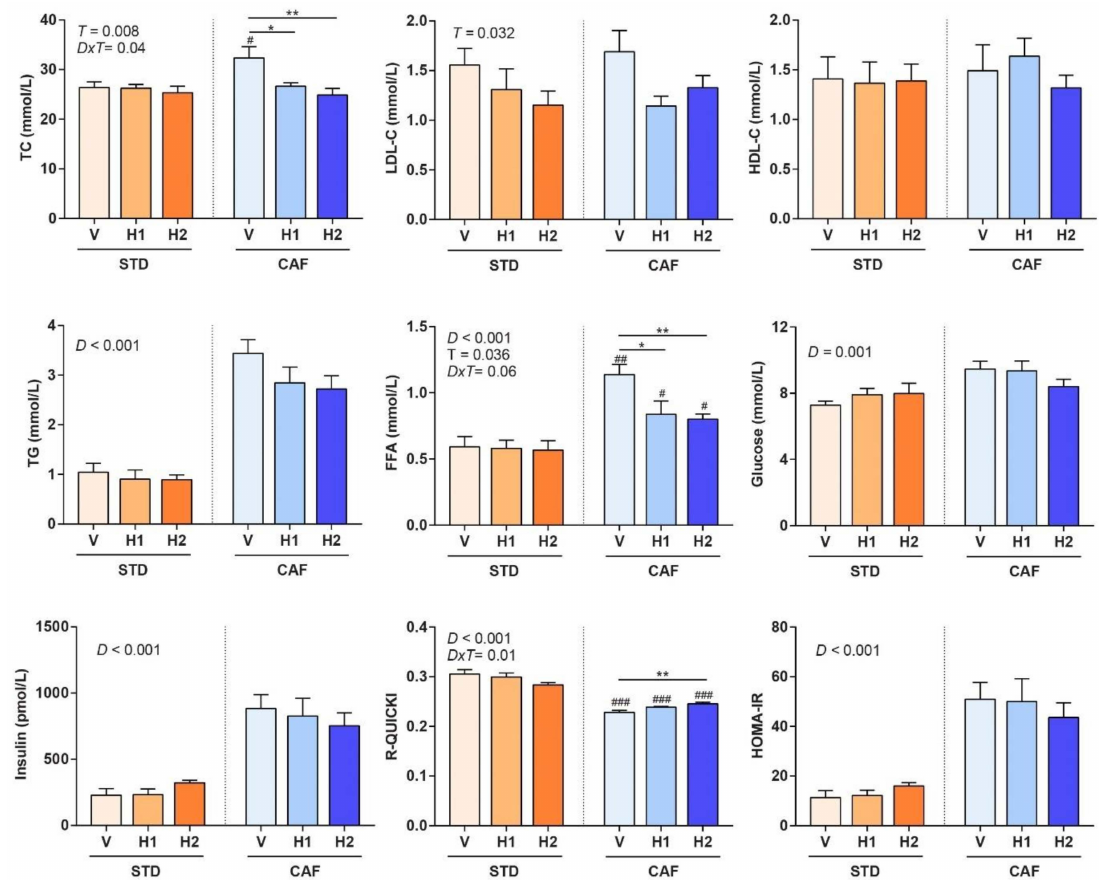
Figure 2. End point (week 18) lipid and glucose metabolism biochemical parameters of rats that were fed with a standard (STD) or a cafeteria (CAF) diet and received a daily oral dose of vehicle (V), hesperidin at 40 mg / kg (H1), or hesperidin at 100 mg / kg (H2), for the last 8 weeks. Data are given as means ± SEM. D : Diet e ff ect; DxT : diet-treatment interaction; T : treatment e ff ect. # p < 0.05, ## p < 0.01, ### p < 0.001 vs the corresponding supplementation group in the STD diet model. * p < 0.05, ** p < 0.01 vs the V group in the same dietary model. FFA, free fatty acids; HOMA-IR, Homeostatic model assessment of insulin resistance; R-QUICKI, revised quantitative insulin sensitivity check index; TC, total